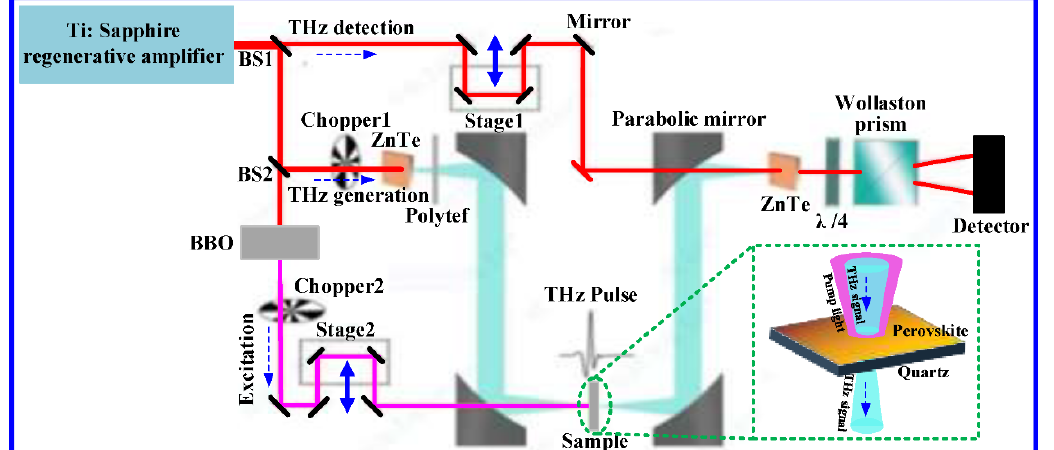
Figure 4. Schematic diagram of the homemade OPTP measurement system.